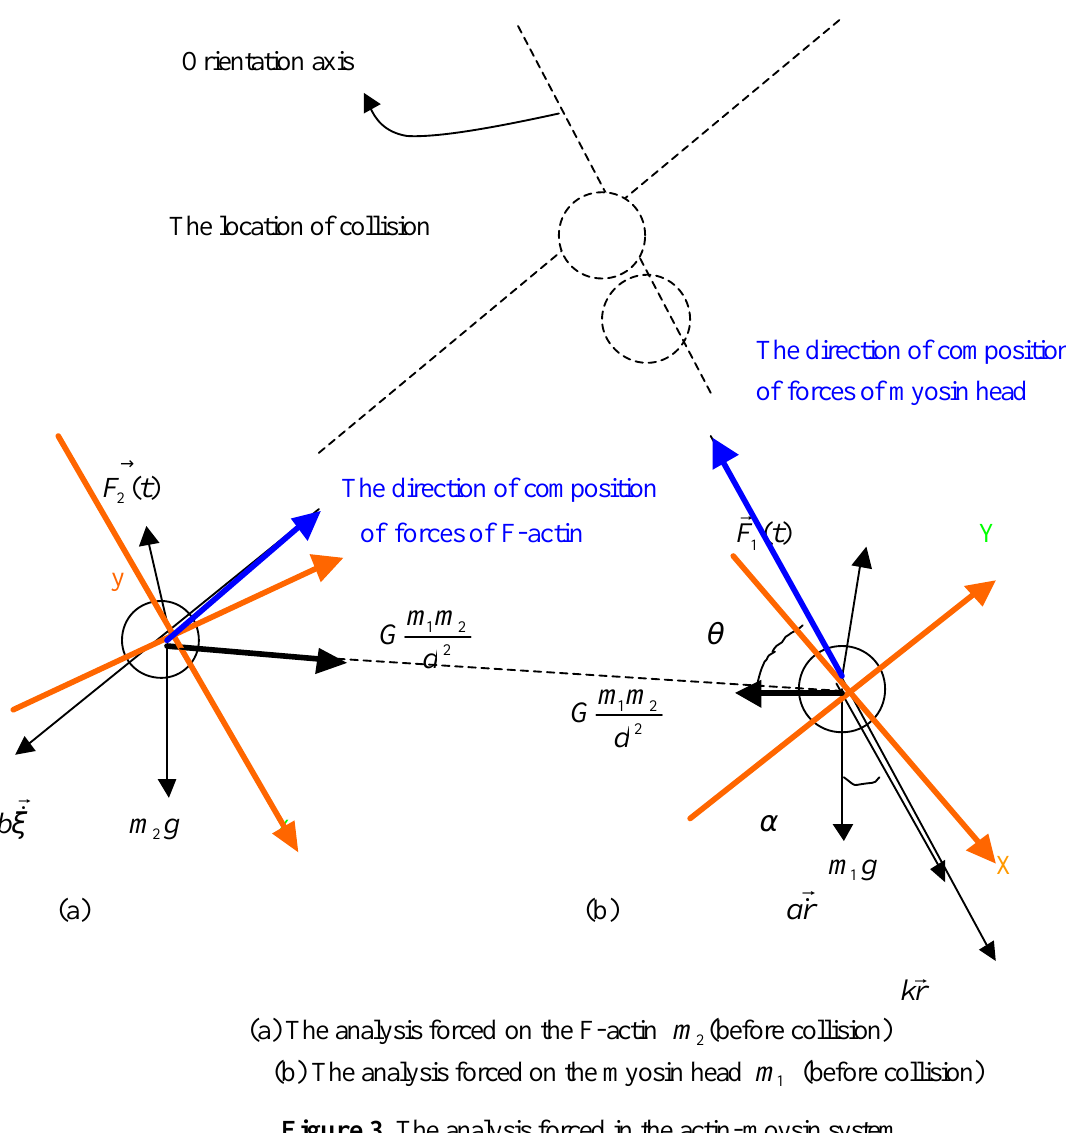
Figure 3. The analysis forced in the actin-moysin